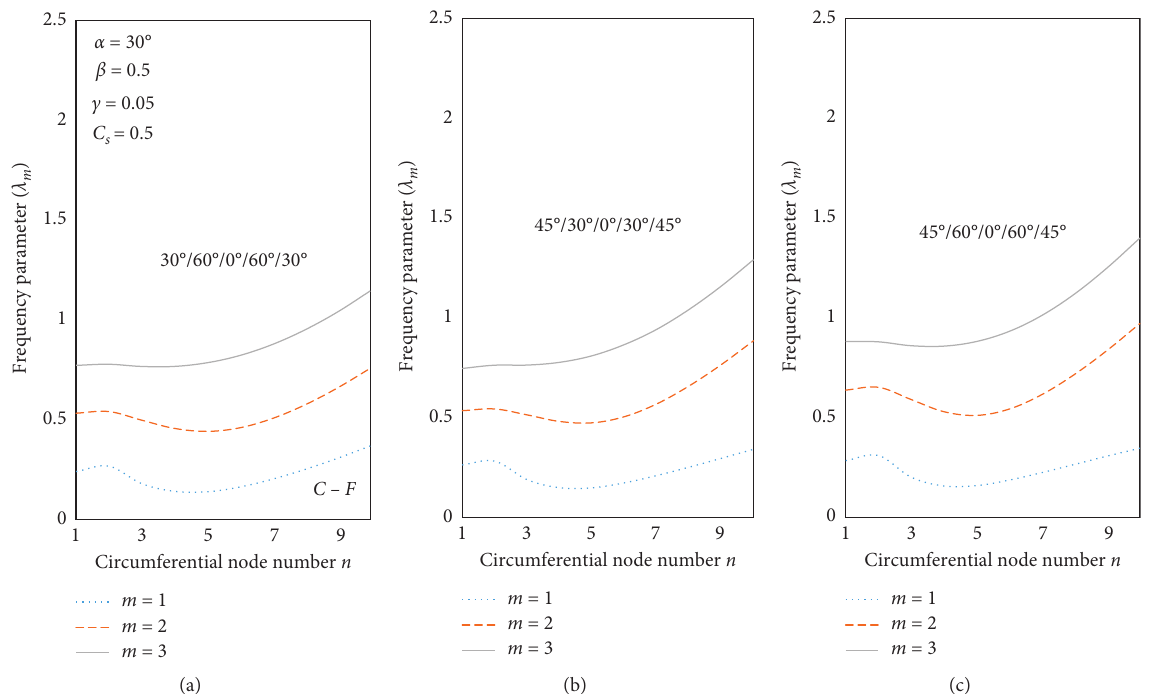
Figure 17: Influence of circumferential node number on the frequency parameter of five-layered conical shells with KE/EGE/GE/EGE/KE material